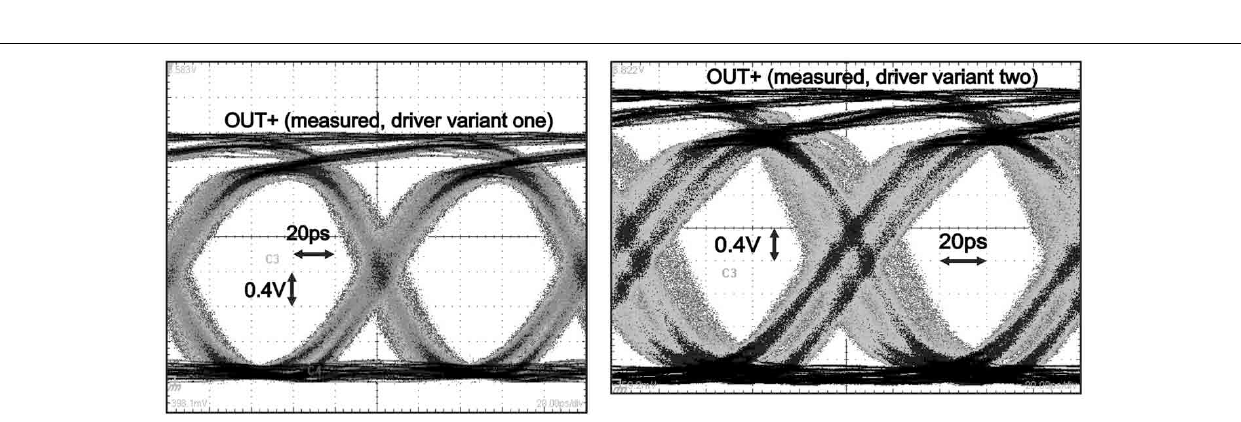
(V CC1 = 2 . 5 V, V CC2 = 3 . 5 V) are depicted. There an extinction ratio of 3.3 dB at a DC tuning voltage V DC = 1 . 2 V at 10 Gb/s and 5.1 dB extinction ratio (V DC = 1 . 2 V) at 5 Gb/s have been reached. On the right side of Figure 13 the eye diagrams for the device with 2 mm long RF phase shifters in each modula- tor arm with driver variant two (V CC1 = 2 . 5 V, V CC2 = 4 . 2 V) are shown. There extinction ratios of 8.4 dB at V DC = 7 V at 10 Gb/s data rate and 8 dB (V DC = 6 V) at 5 Gb/s have been measured. The noise power, which was generated by the